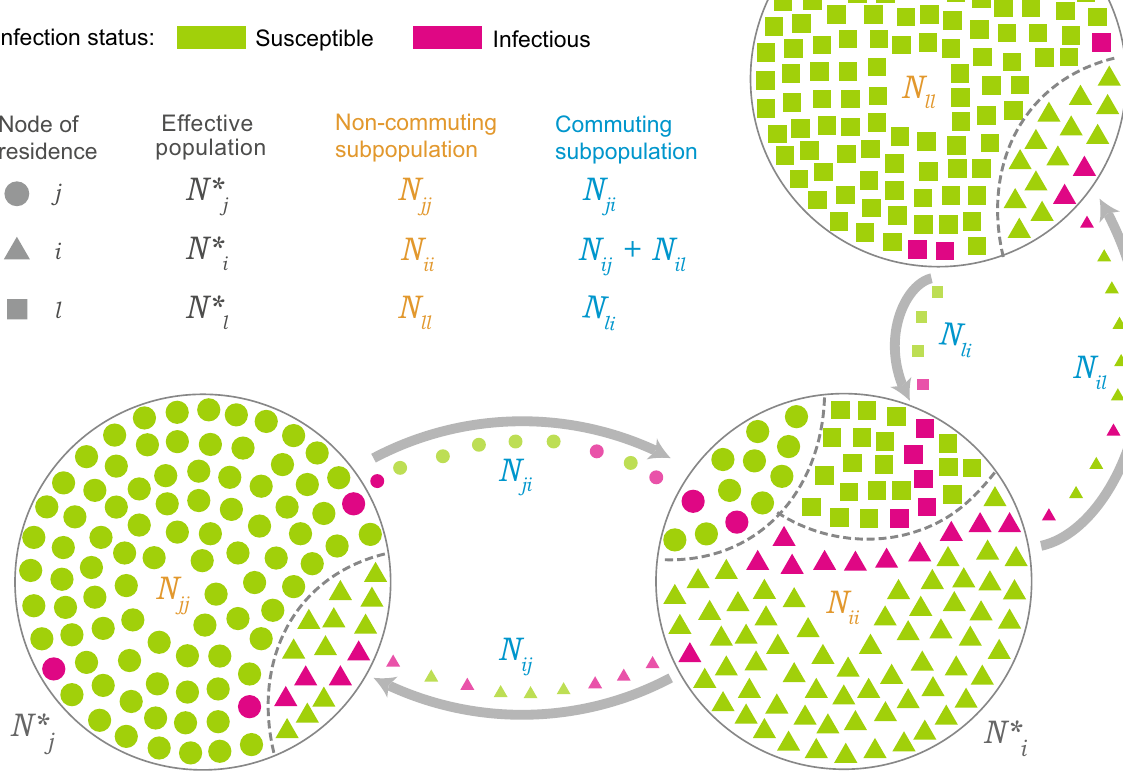
Figure 3. Schematic representation of the commuting flow and how it relates with effective populations and the force of infection. Each node population is divided into subpopulations N xy , where x represents the node of residence and y represents the node of the actual location at time t . Hence, N jj refers to the individuals of node j that remain in j , N ji refers to individuals of node j commuting to node i , and N ∗ j refers to the effective population of node j taking into account its commuting and non-commuting individuals. Three nodes are shown in the figure – i , j , and l – to represent the various contributions to the force of infection (Eq.